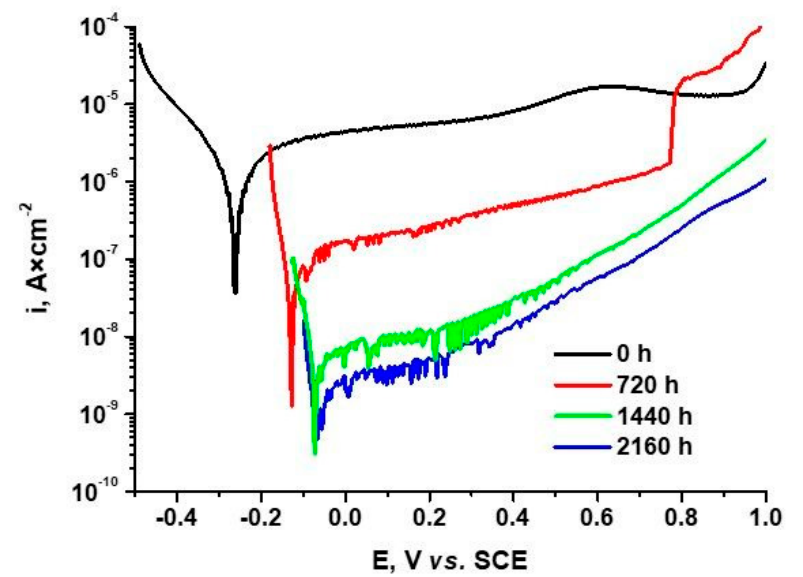
Figure 8. Potentiodynamic plots for unoxidized and oxidized 310 H samples in water at a supercritical temperature (550 °C and 250 atm.).